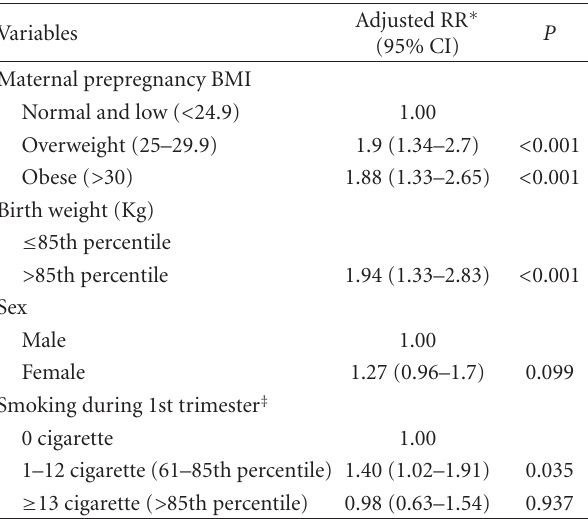
CI: confidence interval. ∗ Adjusted risk ratio computed using poisson regression model with robust variance estimation. † Based on gestational age and race specific birth weight percentiles for US population. ‡ Cigarettes smoked per